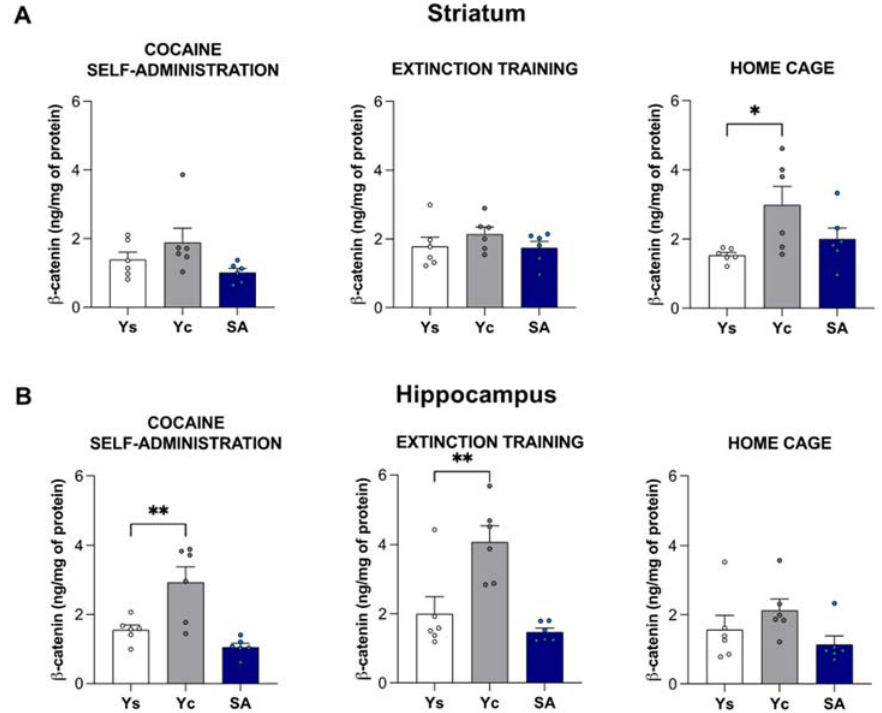
Figure 6. The protein level of β -catenin in the striatum ( A ) and hippocampus ( B ) after 14 days of cocaine self-administration (0.5 mg/kg/inf.) and 3 days of extinction training or cocaine abstinence in the home cage. n = 6 rats/group. Significance was determined using a one-way ANOVA and the post hoc Dunnett’s test. * p < 0.05, ** p < 0.01 versus the yoked saline (Ys) control group. SA: cocaine self-administration group; Yc: yoked cocaine group.